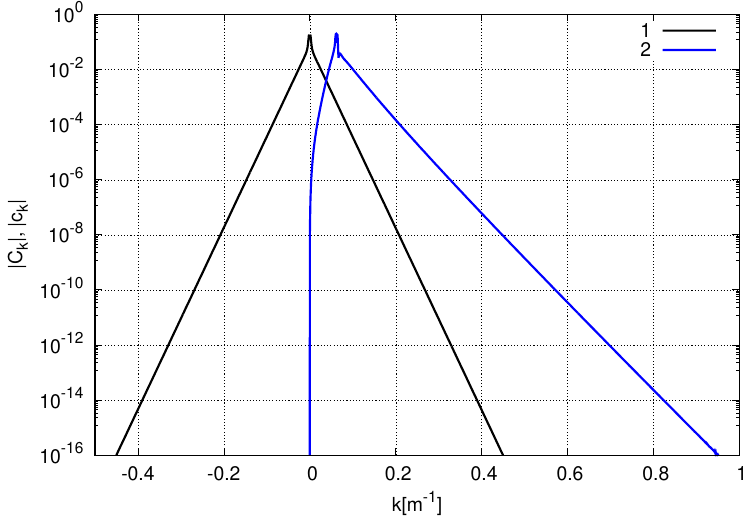
Figure 13. Spectra of | C k | and | c k | in logarithmic scale at the moment of appearance of a single high amplitude wave on the free surface t ≈ 2.8 h. Black solid curve 1 corresponds to the NLS model, blue solid curve 2—to the SCZ equation.